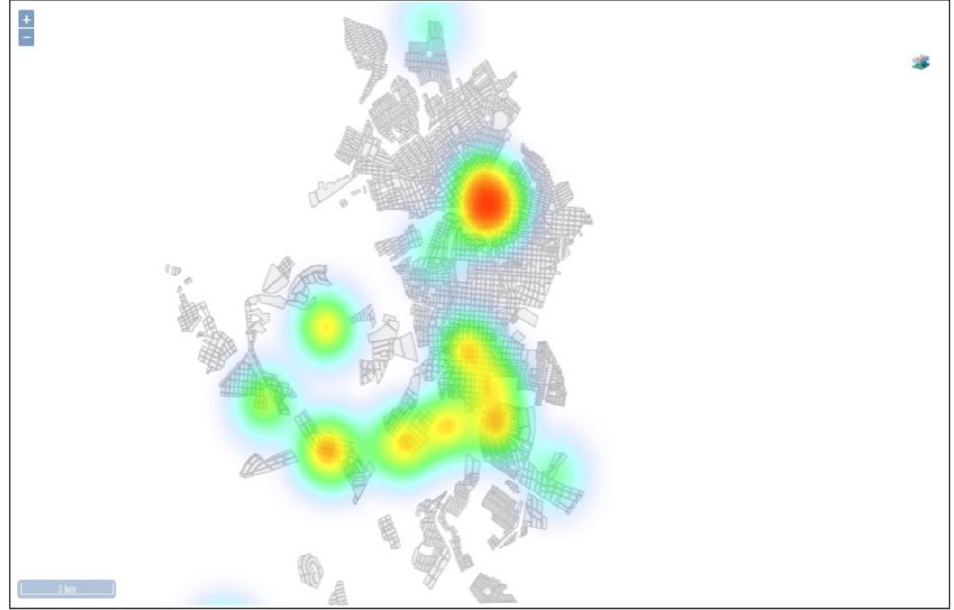
Figure 11 . Hot spot map, showing priority areas of dengue transmission.